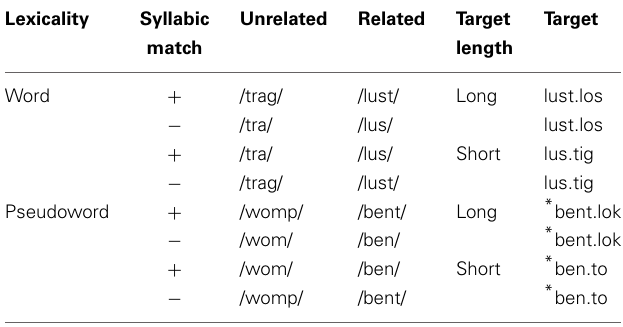
Note: A dot marks a syllable boundary. An asterisk marks a pseudoword.